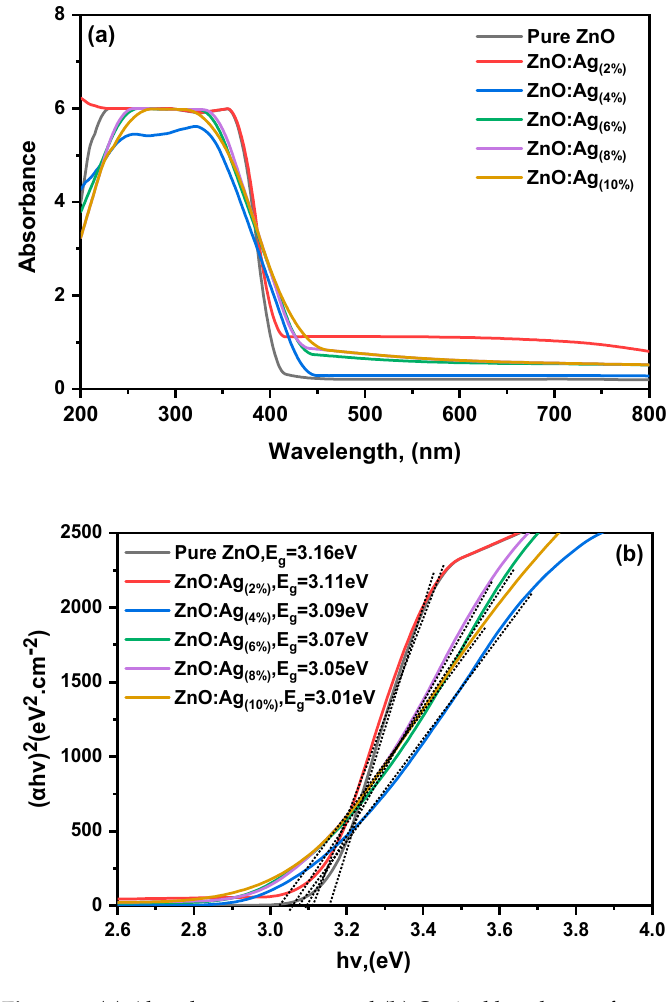
Figure 7. ( a ) Absorbance spectra, and ( b ) Optical band gap of pure and Ag-doped ZnO submicron structures.